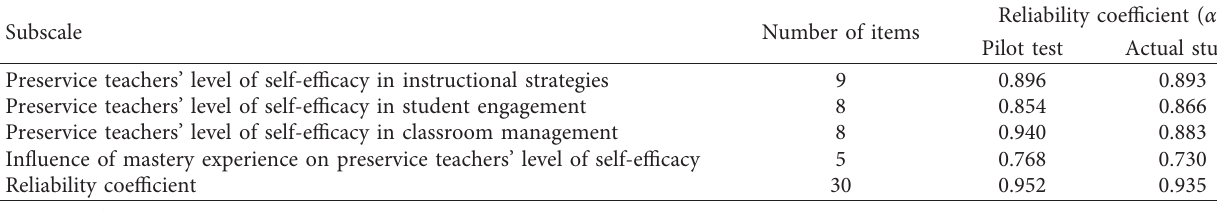
Table 1: Reliability coefficients of subscales on questionnaire.